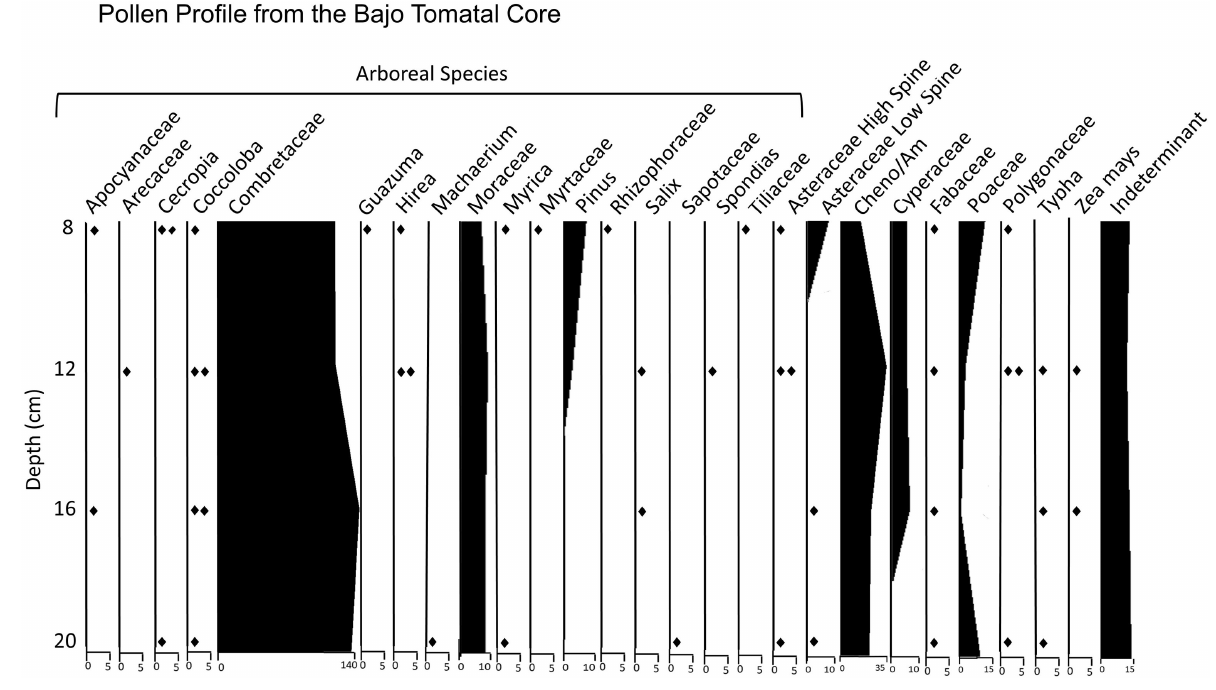
Frontiers in Ecology and Evolution |